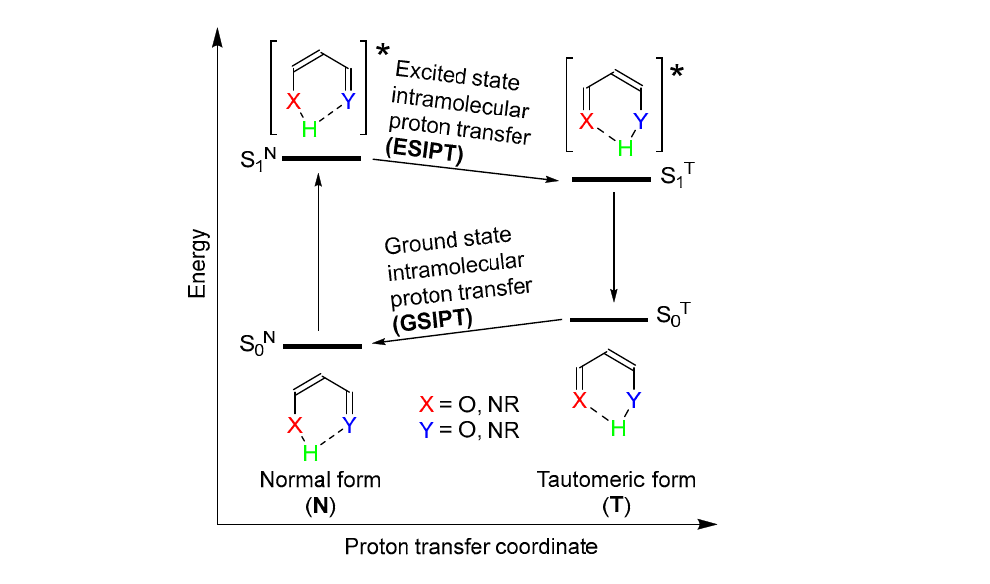
Scheme 1. The ESIPT and GSIPT processes in molecules featuring short intramolecular hydrogen